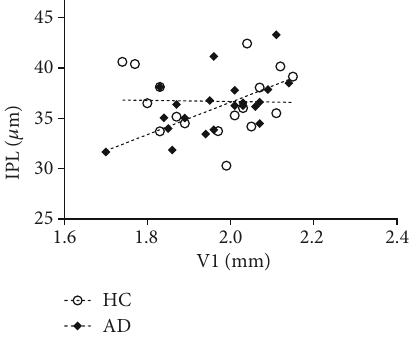
; (c) V1 thickness. There is ND (b) or in V1 thickness (c). ND